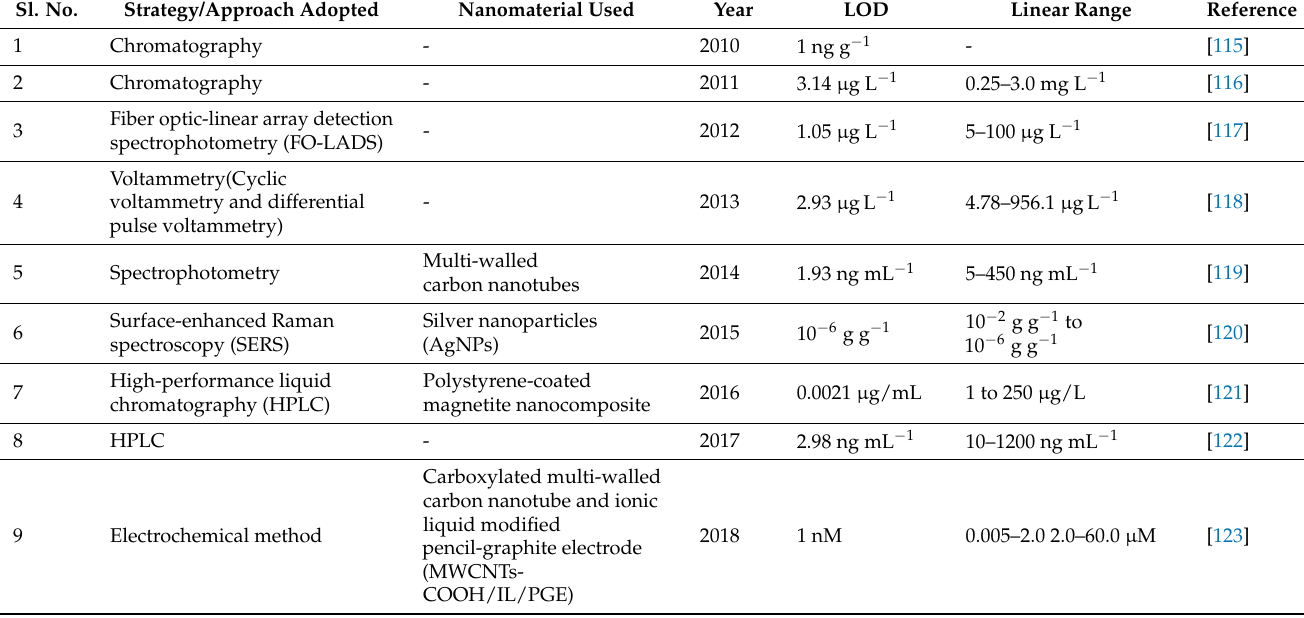
Table 1. Comparison of the performance of the techniques/strategies developed to detect rhodamine B with the SPCE platform using cryosorets, presented along with their limit of detection (LOD) and the linear sensing